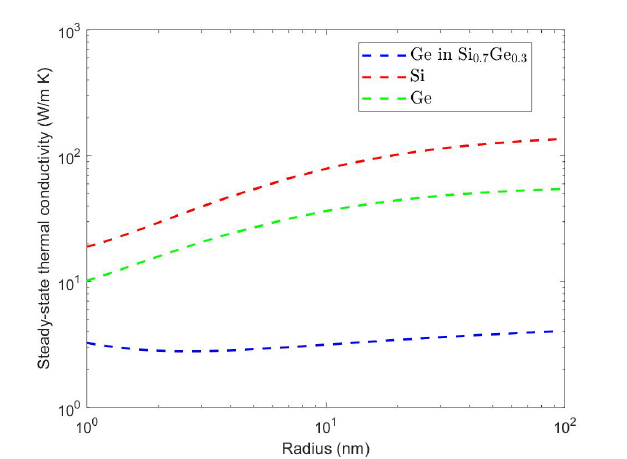
Figure 10. Steady-state thermal conductivity versus R for nanocomposites with 0.2% volume fraction of Ge in Si, in Ge and in Si 0.7 Ge 0.3 , respectively, at T = 300 K.